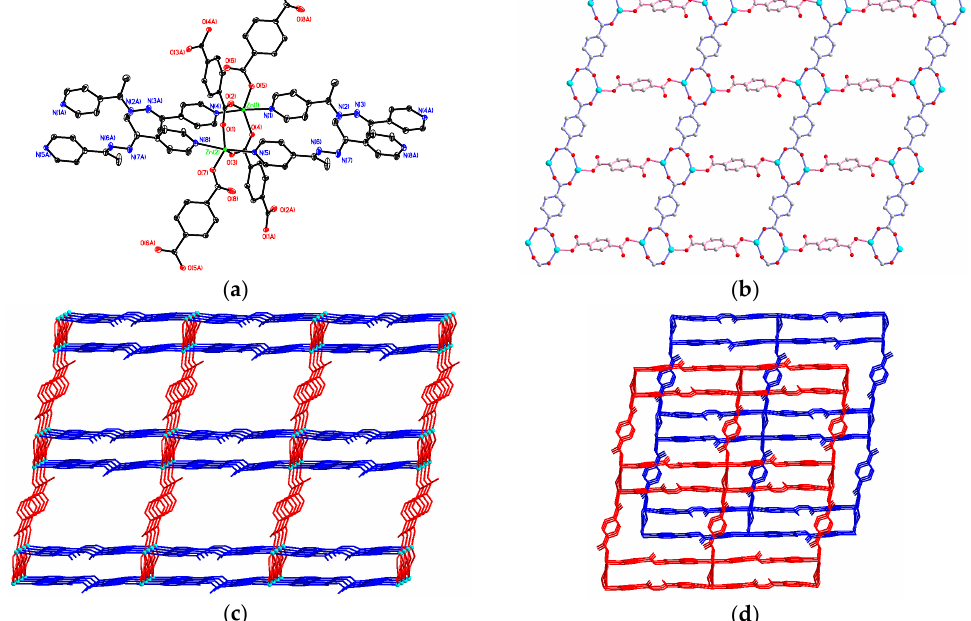
Figure 3. ( a ) Distorted trigonal bipyramidal coordination environments about two Zn(II) ions in 3 with atom labelling scheme (ORTEP drawing, 30% thermal ellipsoids). The guest 4-bpdh molecules and H atoms are omitted for clarity; ( b ) The 2D layered framework constructed by Zn(II) and bdc 2 − ligands with bis -bidentate and bis -monodentate coordination modes; ( c ) The 3D rectangular-box-like MOF; ( d ) The two-fold interpenetrating 3D supramolecular architecture of 3 .